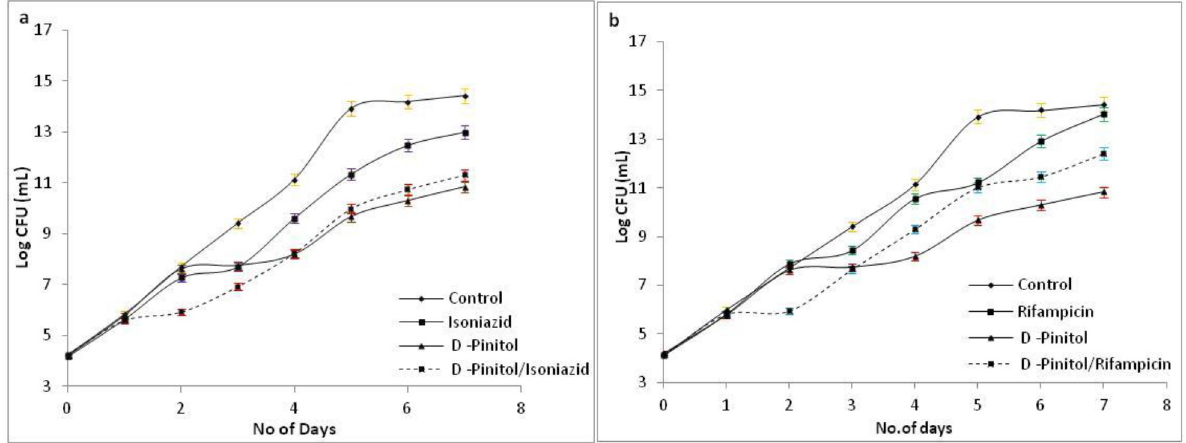
Fig 3. Time kill curves of a) isoniazid, b) rifampicin in combination with the phytochemical D-Pinitol against M . smegmatis .